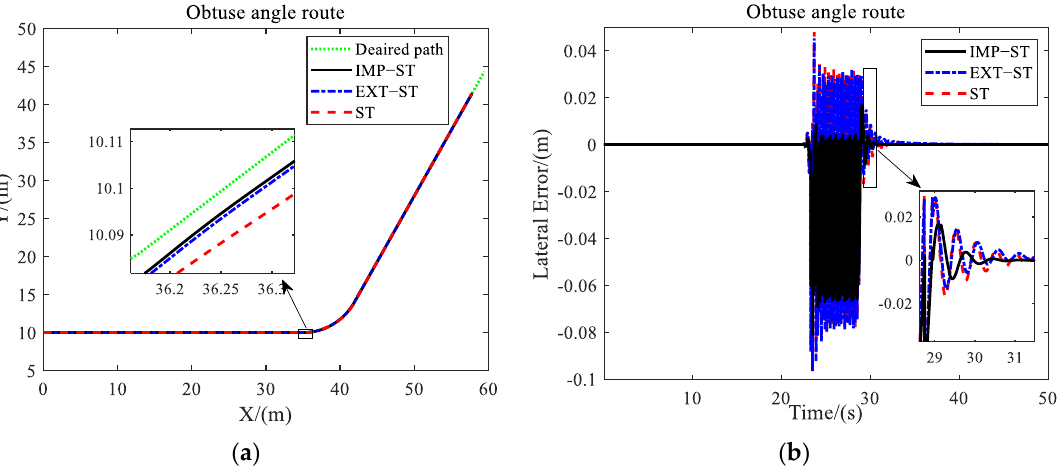
Figure 12. Path tracking performance comparison of three controllers for the obtuse angle route. ( a ) trajectory; ( b ) lateral error.